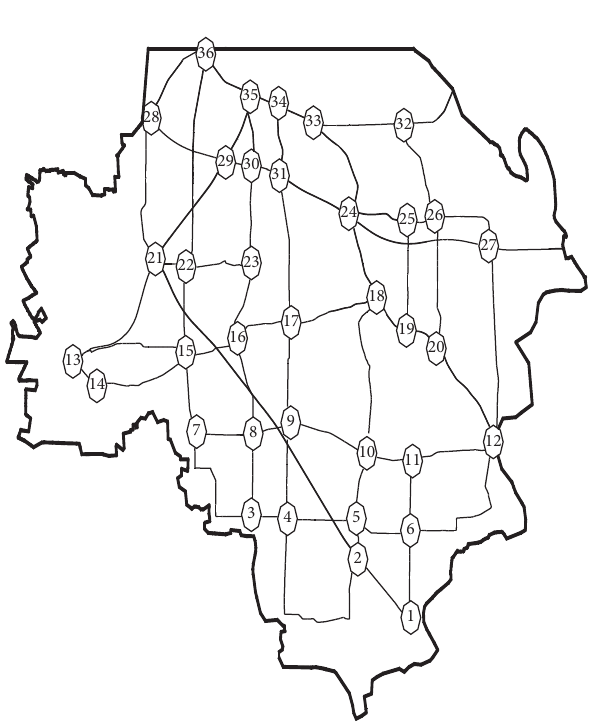
Figure 7: Road network of City